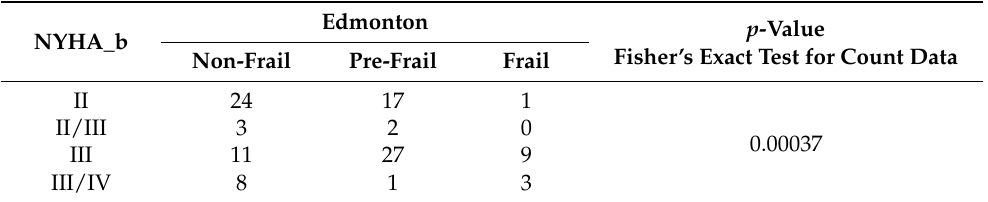
Table 2. Edmonton variables contingency table—NYHA class at the beginning of hospitalization.